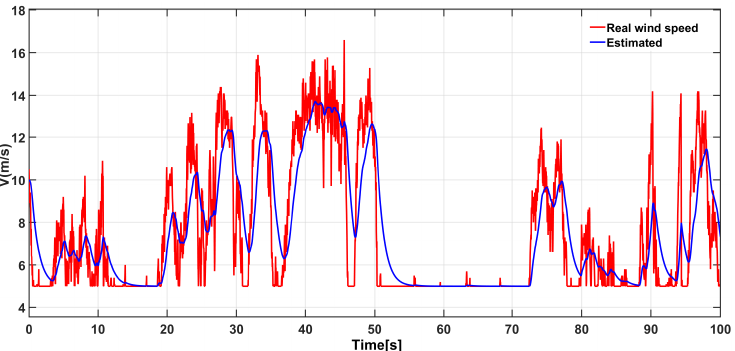
Figure 13. Estimated real wind speed profile.